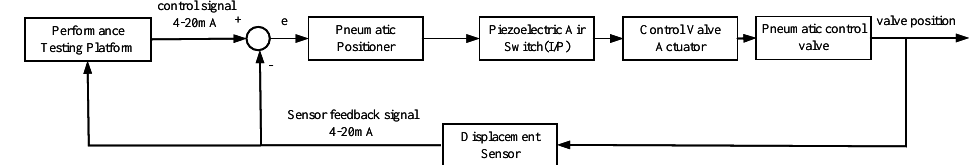
Figure 17. Control system of the pneumatic control